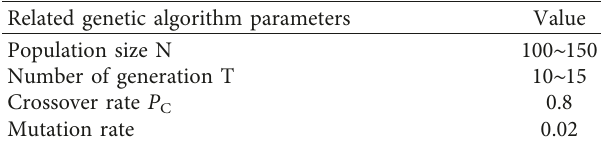
Table 3: Parameter settings of the genetic algorithm. Related genetic algorithm